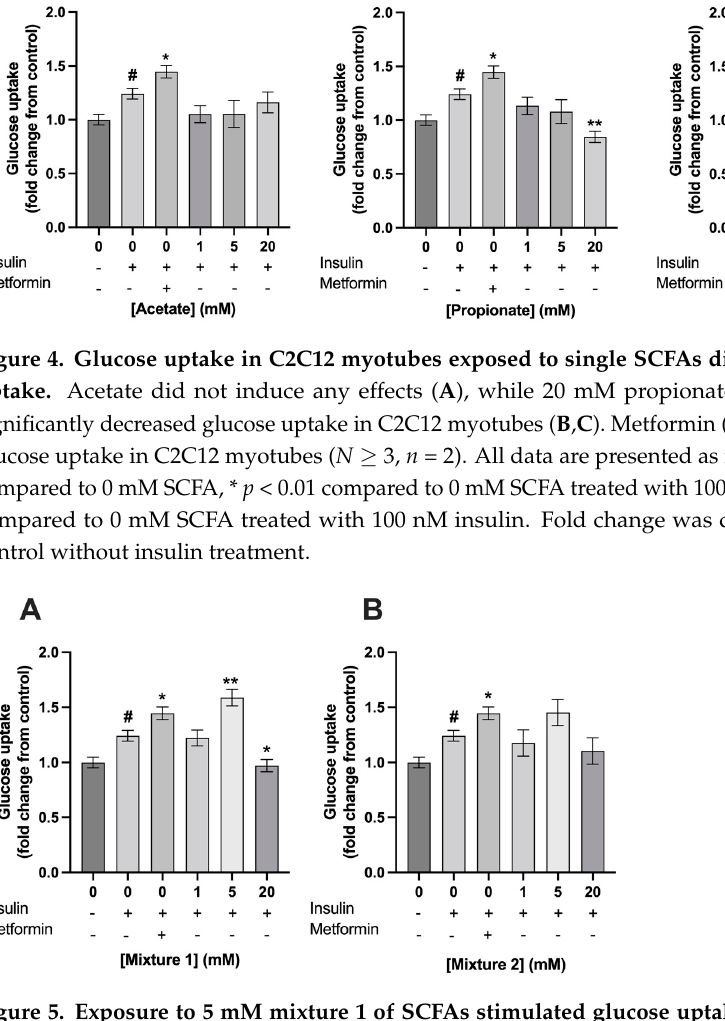
Figure 5. Exposure to 5 mM mixture 1 of SCFAs stimulated glucose uptake in C2C12 myotubes. A 24 h exposure to mixture 1 at 5 mM increased glucose uptake in C2C12 myotubes ( A ). In addition, a similar trend was seen for mixture 2 ( B ). Metformin (400 μ M, 24 h) increased glucose uptake in C2C12 myotubes (N ≥ 3, n = 2). All data are presented as mean ± SEM. # p < 0.01 compared to 0 mM SCFA * p < 0.01 compared to 0 mM SCFA treated with 100 nM insulin; ** p < 0.001 compared to 0 mM SCFA treated with 100 nM insulin. Fold change was calculated compared to control without insulin treatment.